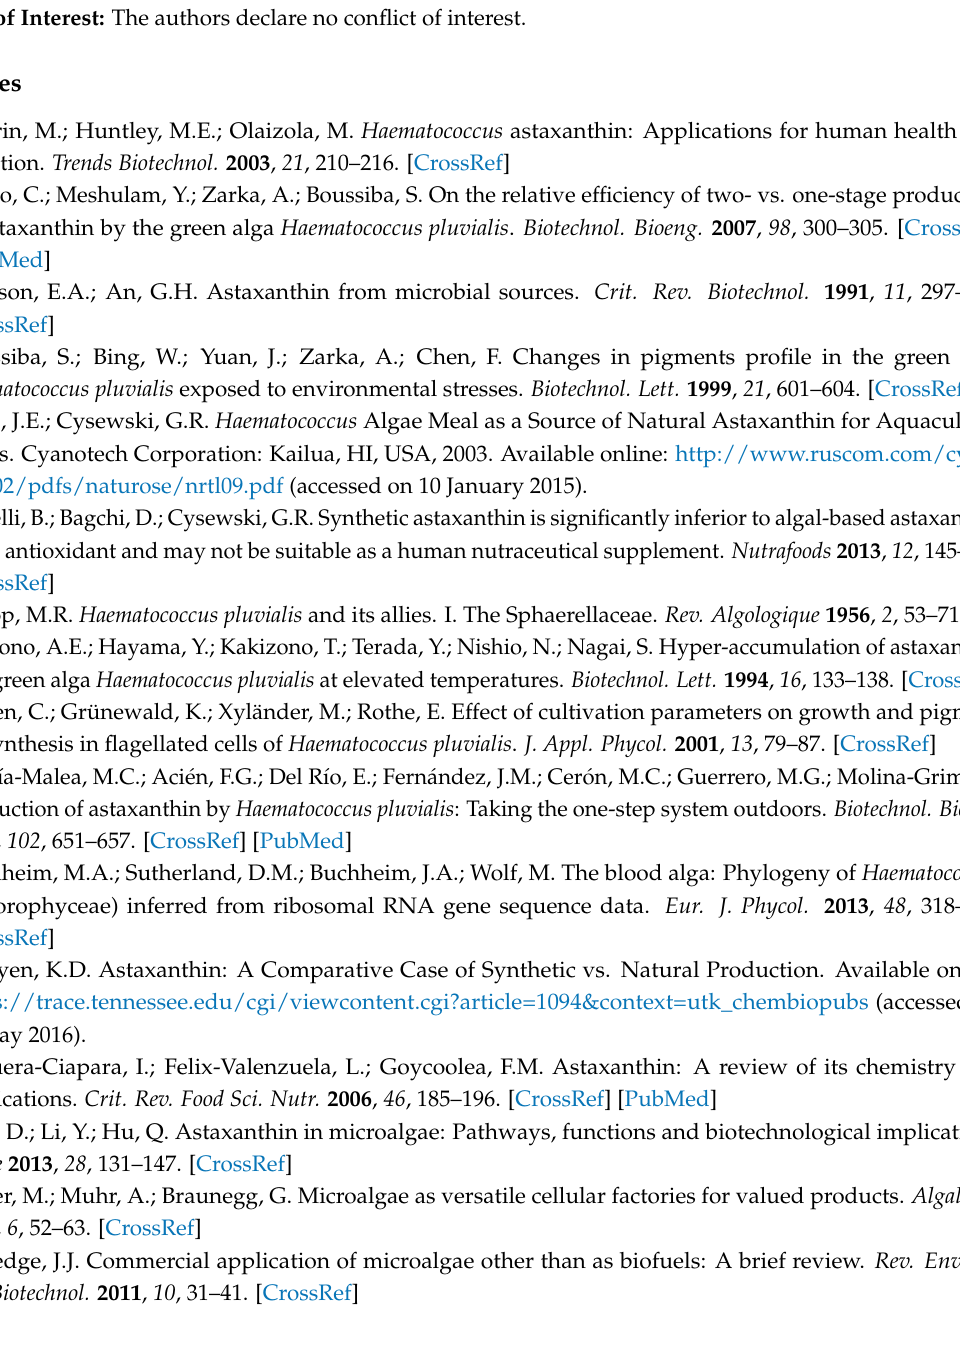
Table S3: Chemical composition of autotrophic and mixotrophic media used in the initial medium preference study for the green stage, Table S4: Composition of FM:FB. Nutrient concentrations (guaranteed minimum concentrations) in mg · L − 1 calculated from GHE, France, Figure S1: Identification of carotenoid peaks by Liquid Chromatography-Mass Spectrometry (LC-MS), Table S5: Liquid Chromatography Mass Spectrometry